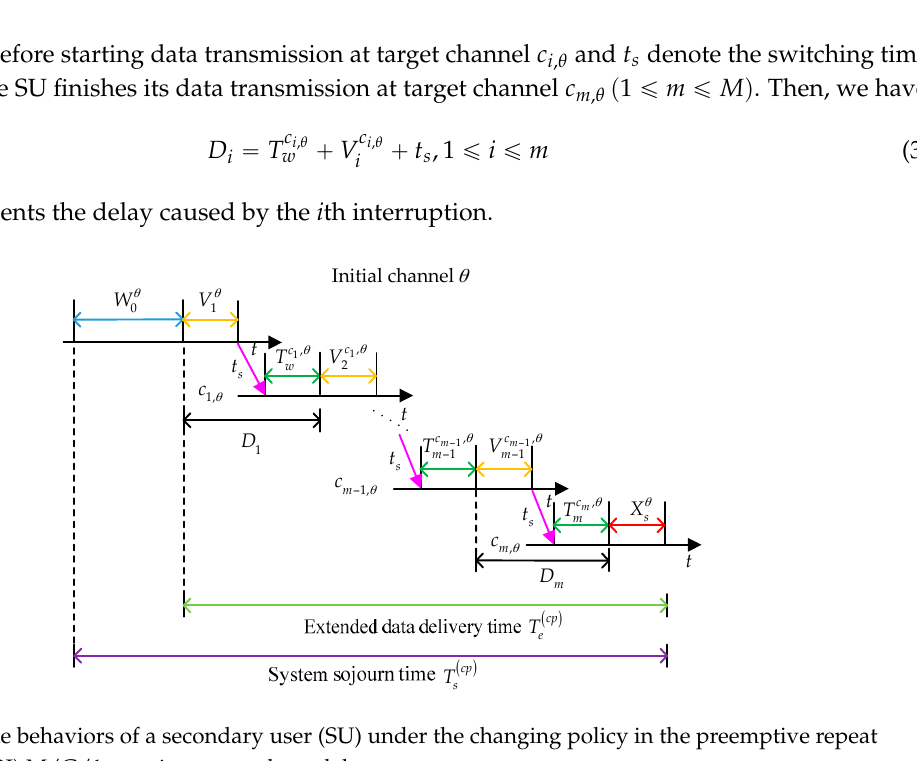
Figure 2. The behaviors of a secondary user (SU) under the changing policy in the preemptive repeat identical (PRI) M/G/1 queuing network model.